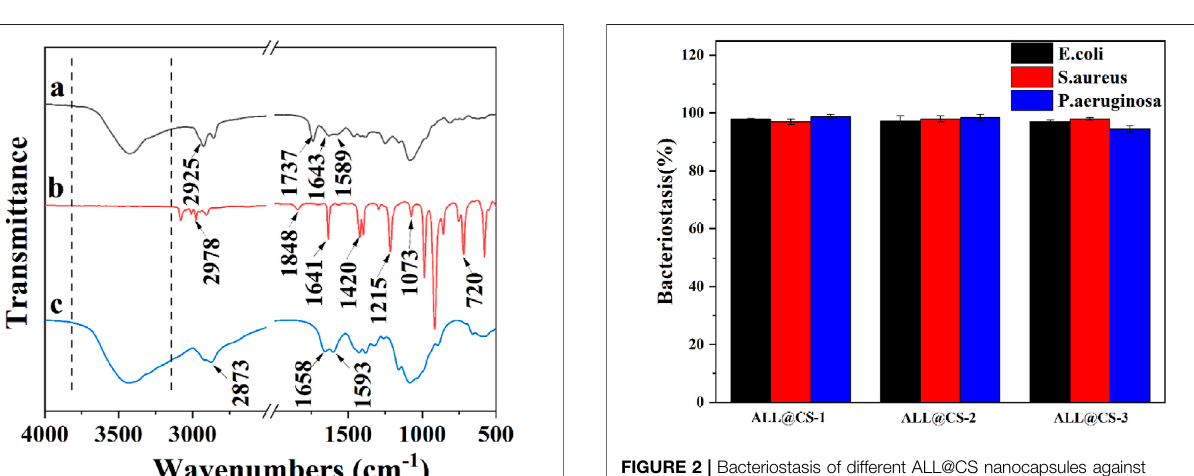
TABLE1| Meanhydrodynamicdiameter,PDI,andzetapotentialofnanocapsules made using different proportions of CS and ALL. No CS (mg)